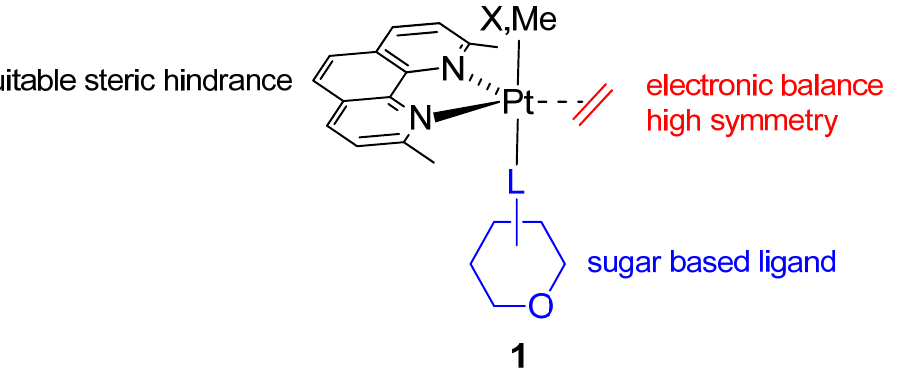
Figure 1. General structure of type 1 complexes.